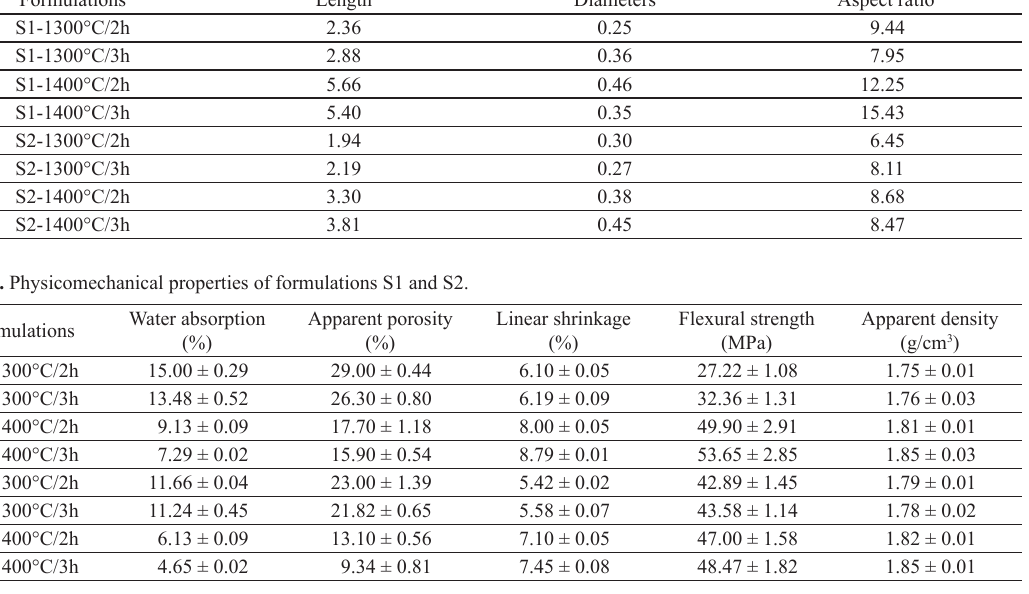
Table 3. Dimensions (in μm) of the mullite needles. Formulations